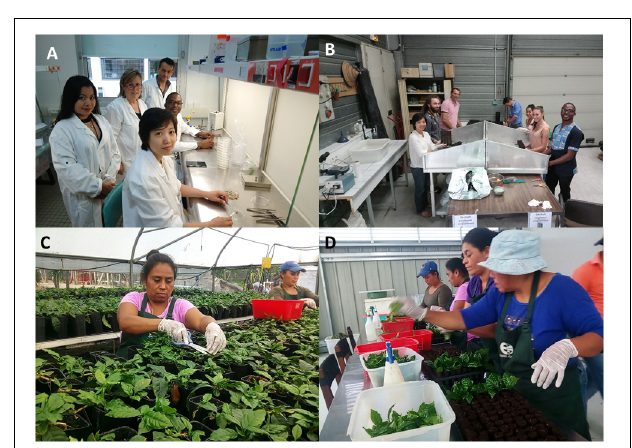
FIGURE 5 | Technology transfer of C. arabica SE and democratization of the rooted mini-cuttings companion method. (A,B) Training in SE at CIRAD (France) for researchers from Cameroon and Vietnam. (C,D) Women’s mini-cuttings cooperative in Nicaragua at the “La Cumplida” farm, Matagalpa